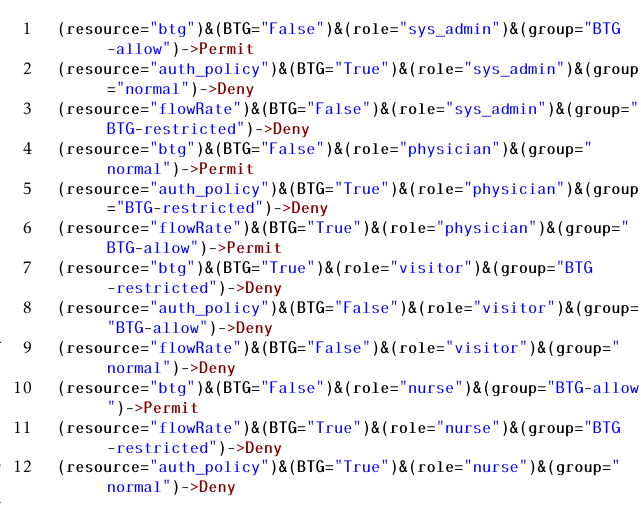
Figure 11. Results of ACPT’s auto-generated heuristic testing, reformatted for readability and with metadata header